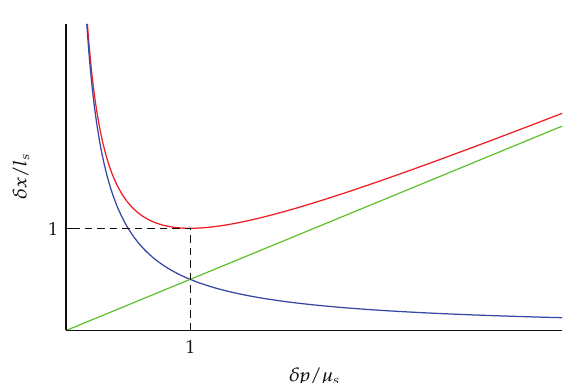
Figure 1: The δp -dependence of the lower bound of δx under the minimal length uncertainty relation (cid:5) 2.1 (cid:6) (cid:5) red curve (cid:6) . The bound for the usual Heisenberg relation δx ≥ (cid:2) / (cid:5) 2 δp (cid:6) is shown in blue, and the linear bound δx ≥ (cid:5) (cid:2) β/ 2 (cid:6) δp is shown in